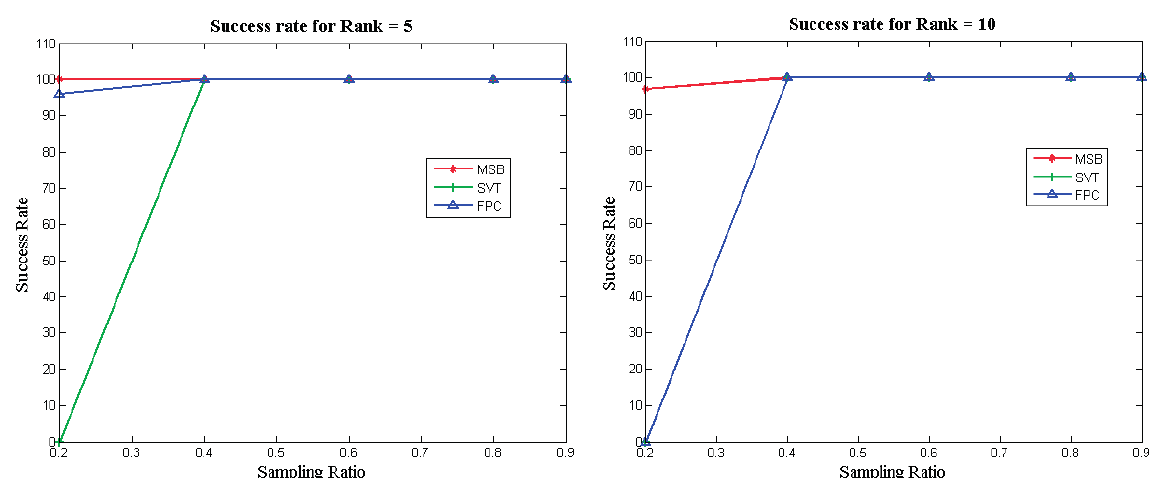
Figure 3. Empirical Success